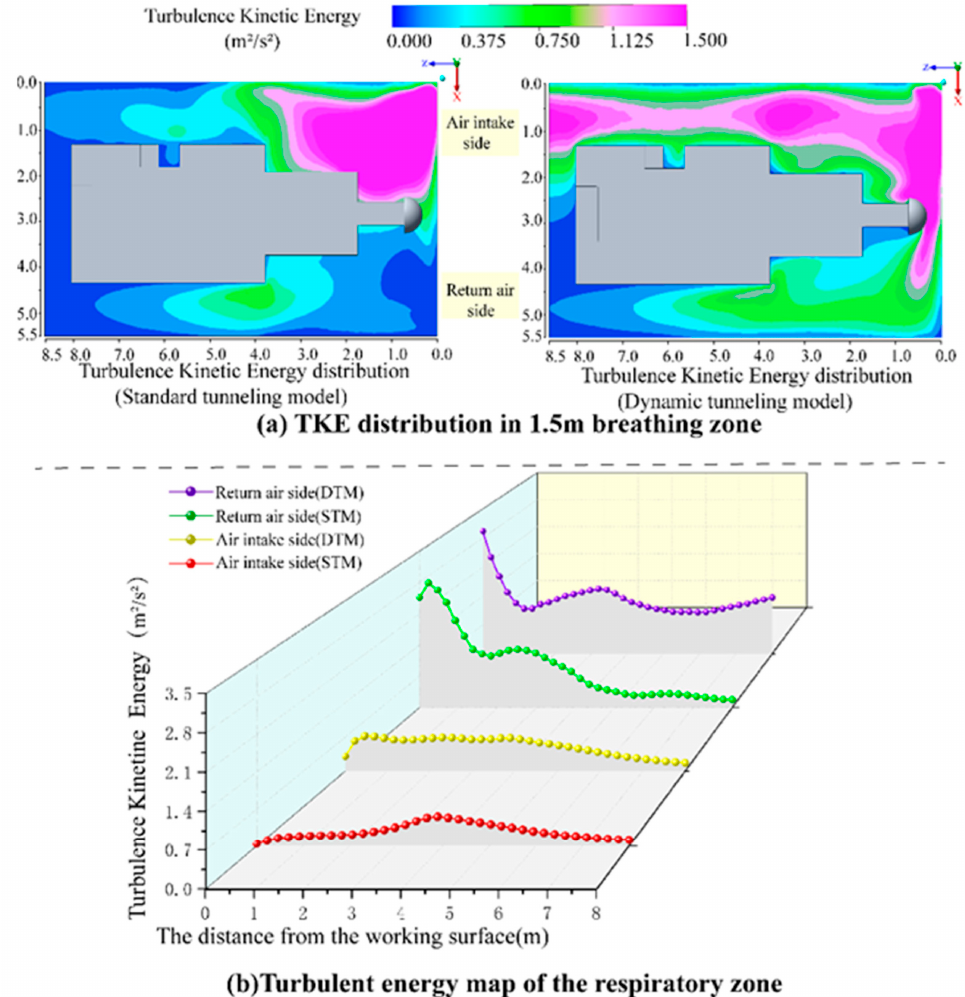
Figure 12. Distribution of TKE in